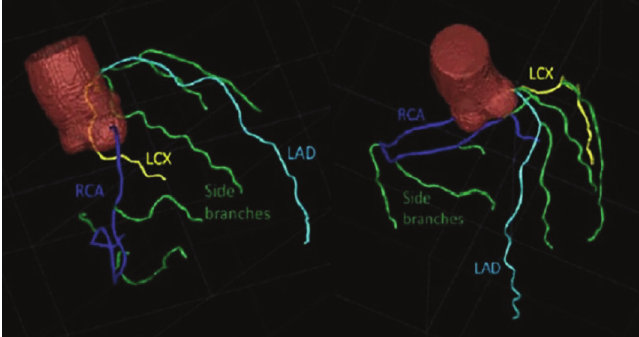
Figure 1. The Cor A algorithm, which includes automated segmentation, midline extraction, and branch marking, displays the right anterior and left anterior oblique of the coronary artery branches and main aorta